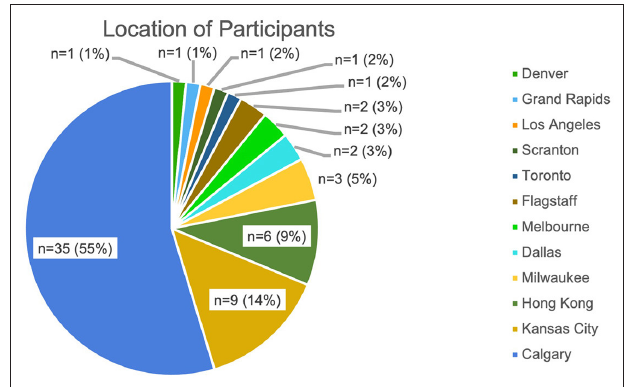
FIGURE 1 | The locations of participants included in the study.